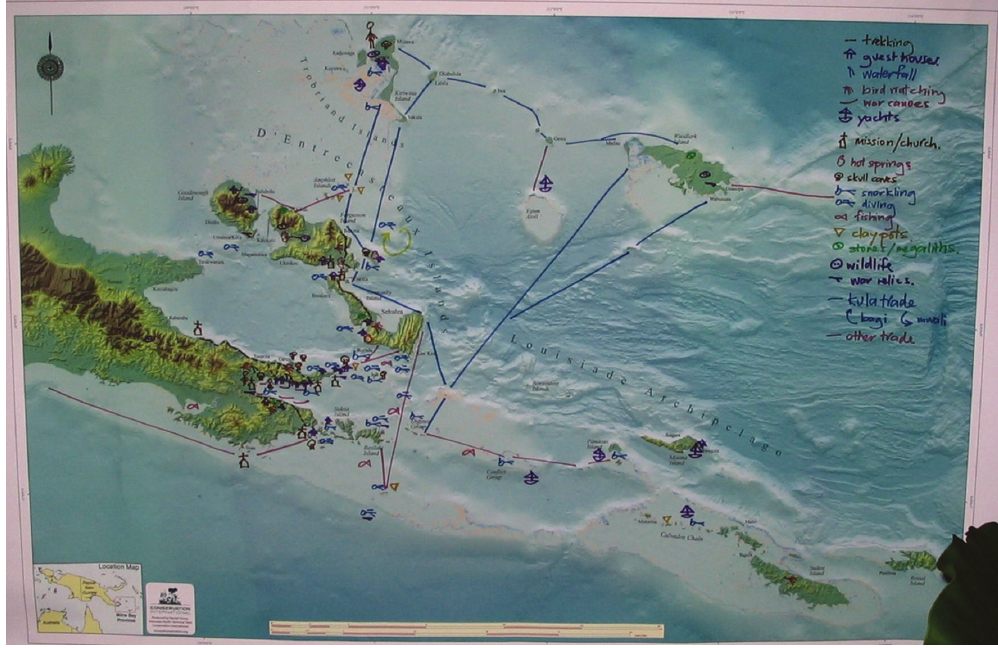
Figure 3: Composite map of important natural and cultural assets supporting ecotourism identified by